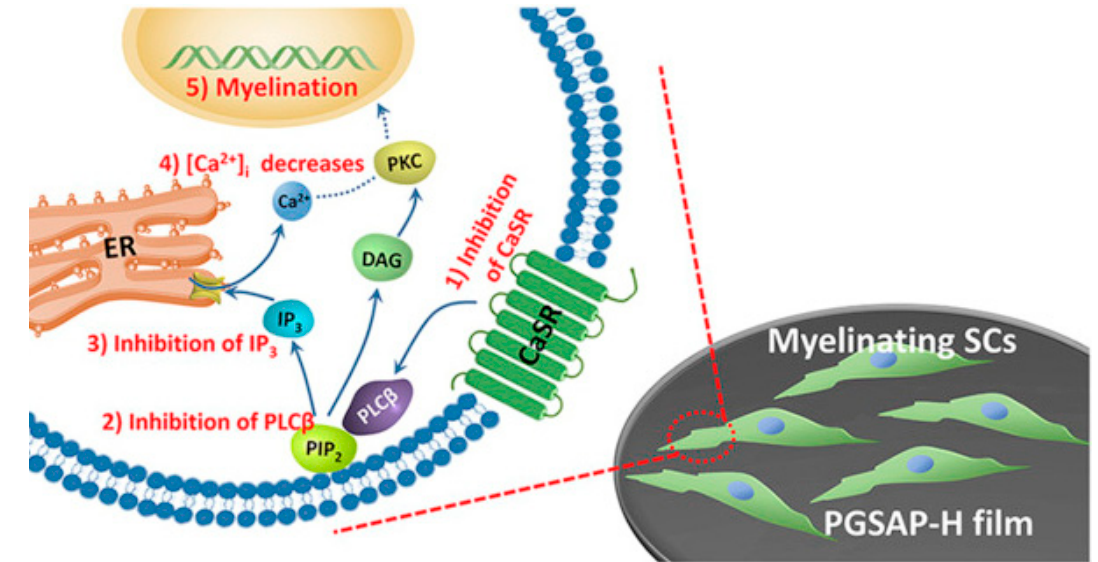
Figure 6. Mechanism of Schwann cells’ (SCs’) myelination on conductive platform. Conductive films inhibit CaSR and PLC β pathway, and then decline the intracellular Ca2 þ level [25], copyright Elsevier, 2016.